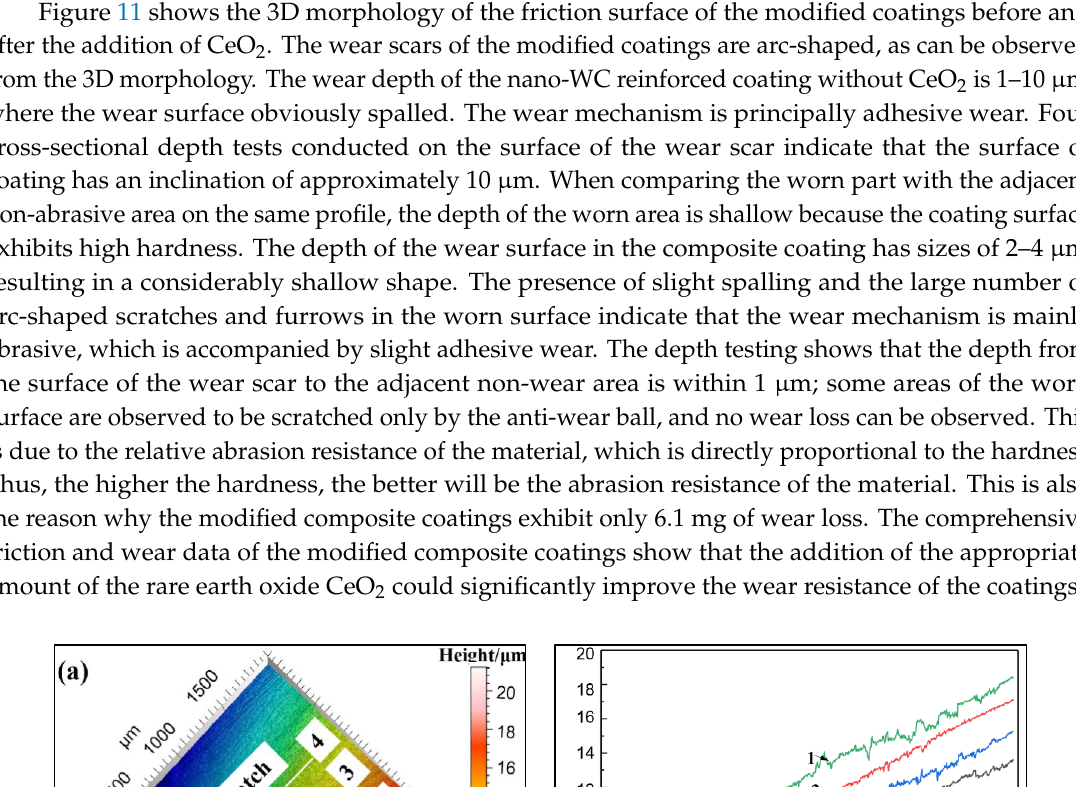
Figure 10. Frictional coefficient of the modified composite coatings containing different amounts of CeO 2.